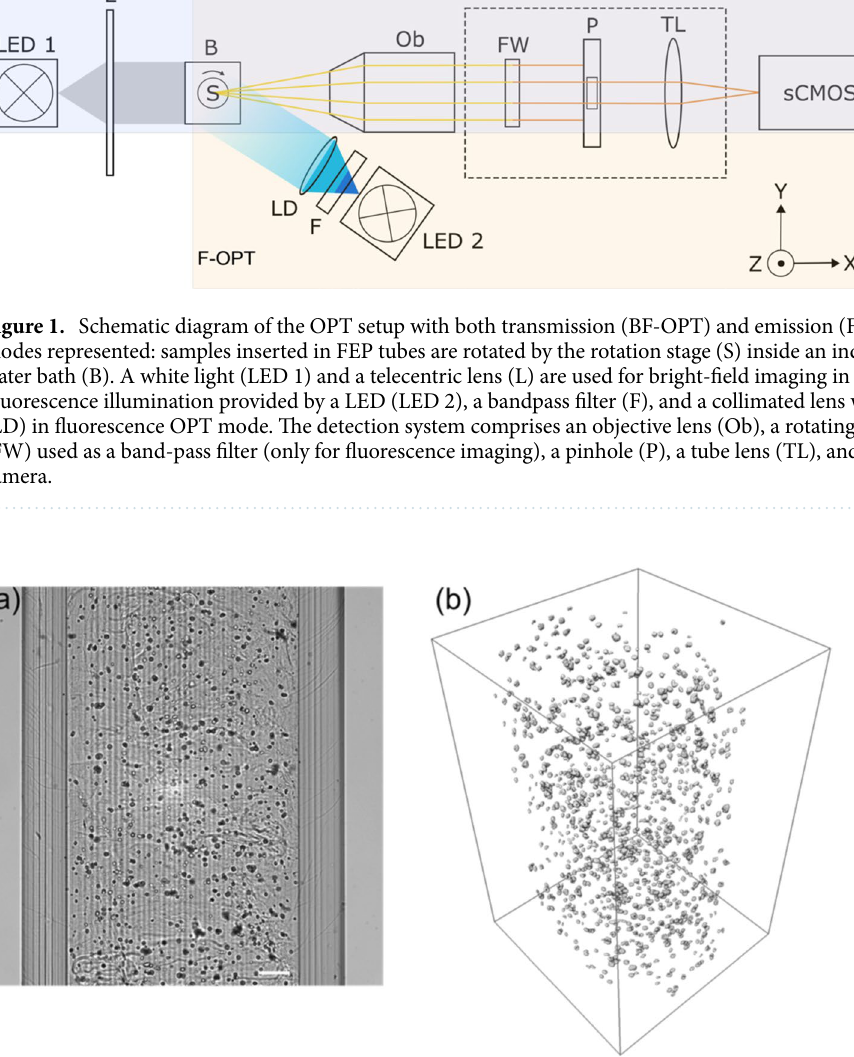
Figure 2. Bright-field OPT imaging of fibroblasts in a 3D GG hydrogel. ( a ) Raw bright-field projection image, and ( b ) 3D visualization of segmented cells. The scale bar indicate 200